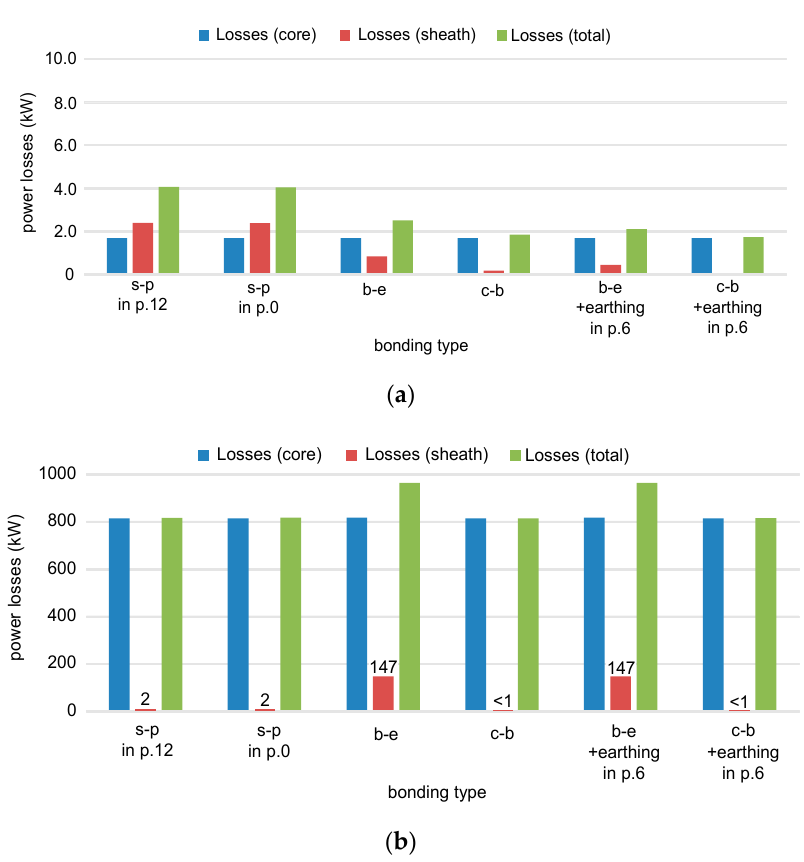
Figure 13. Power losses in the analyzed three-phase cable system: ( a ) for the transferred power 1 MW, tg φ = 0; ( b ) for the transferred power 80 MW, tg φ = 0; s-p: single-point bonding; b-e: both-ends bonding; c-b: cross bonding.